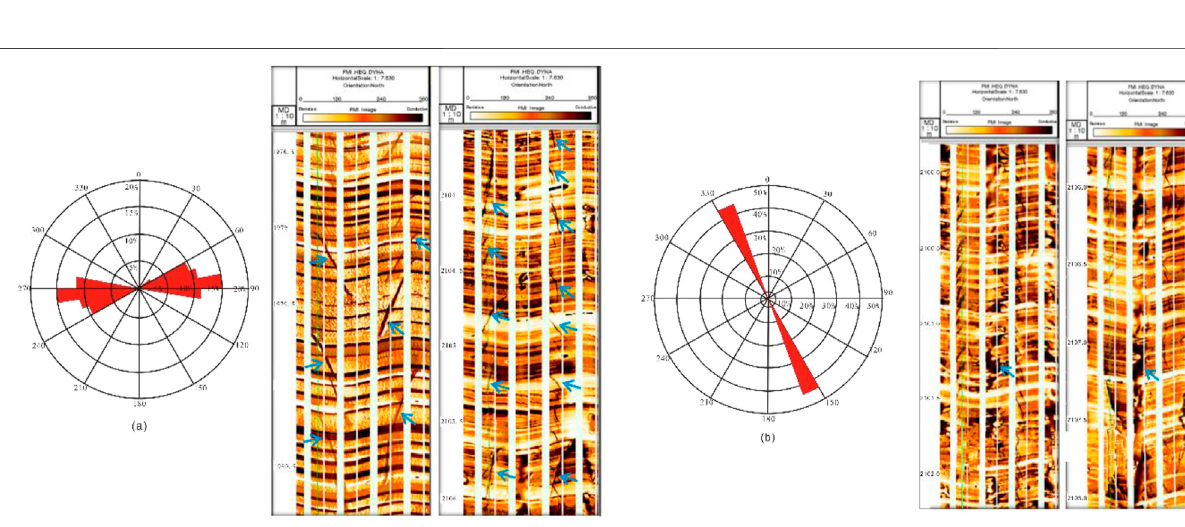
Frontiers in Earth Science |